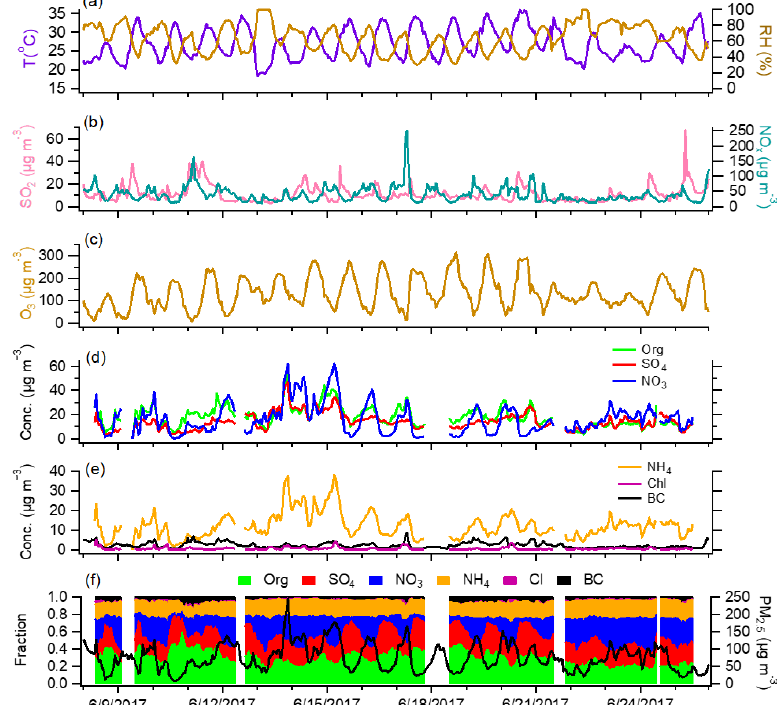
Figure 2. Time series of meteorological parameters, gaseous species, and submicron aerosol species in Xinxiang.